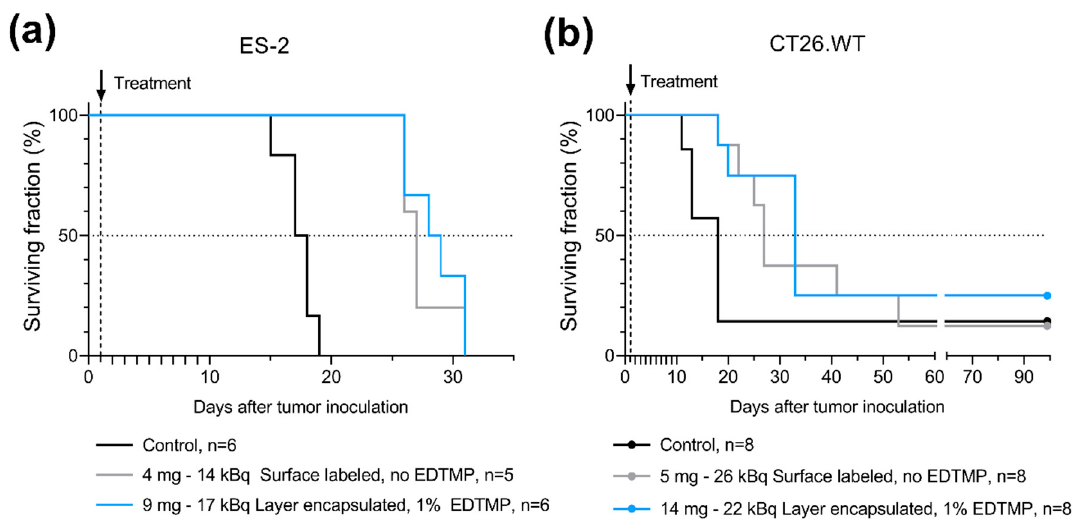
Figure 6. Therapeutic effect of 224 Ra-labeled microparticles; surface-labeled microparticles vs layer-encapsulated surface- labeled microparticles. ( a ) Kaplan–Meier curves of nude mice inoculated with ES-2 cells on day zero. ( b ) Kaplan–Meier curves of BALB/c mice inoculated with CT26.WT cells on day zero. There are censored mice on day 99, corresponding to three times the median survival time of the longest surviving group at which the study was terminated; one mouse is censored on the black and grey curves while two mice are censored on the blue curve.